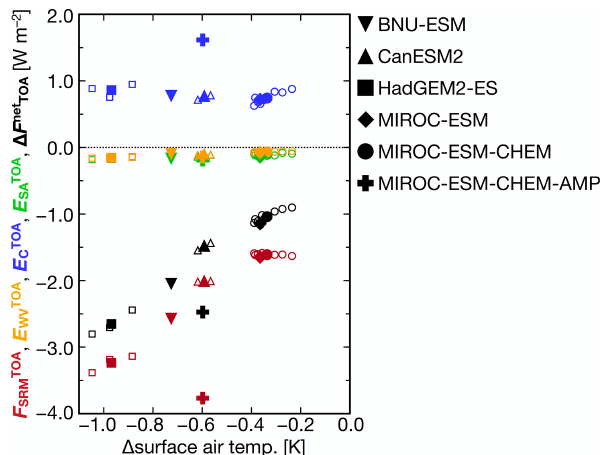
Figure 10. Same as Fig. 5 but the variables except for the surface temperature are calculated at the top of the